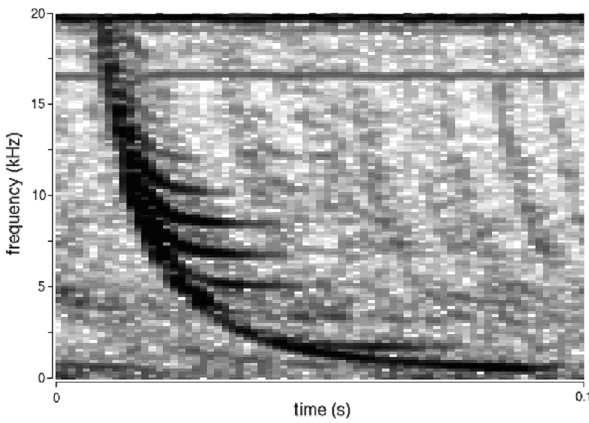
Fig. 1. Spiky whistler in DEMETER ICE burst mode VLF record- ing (orbit: 1242 up, sensor: E34, date: 25 September 2004, 21:30:33.2 UT, satellite position: 34.7N; 5.0E, altitude: 702.3, L: